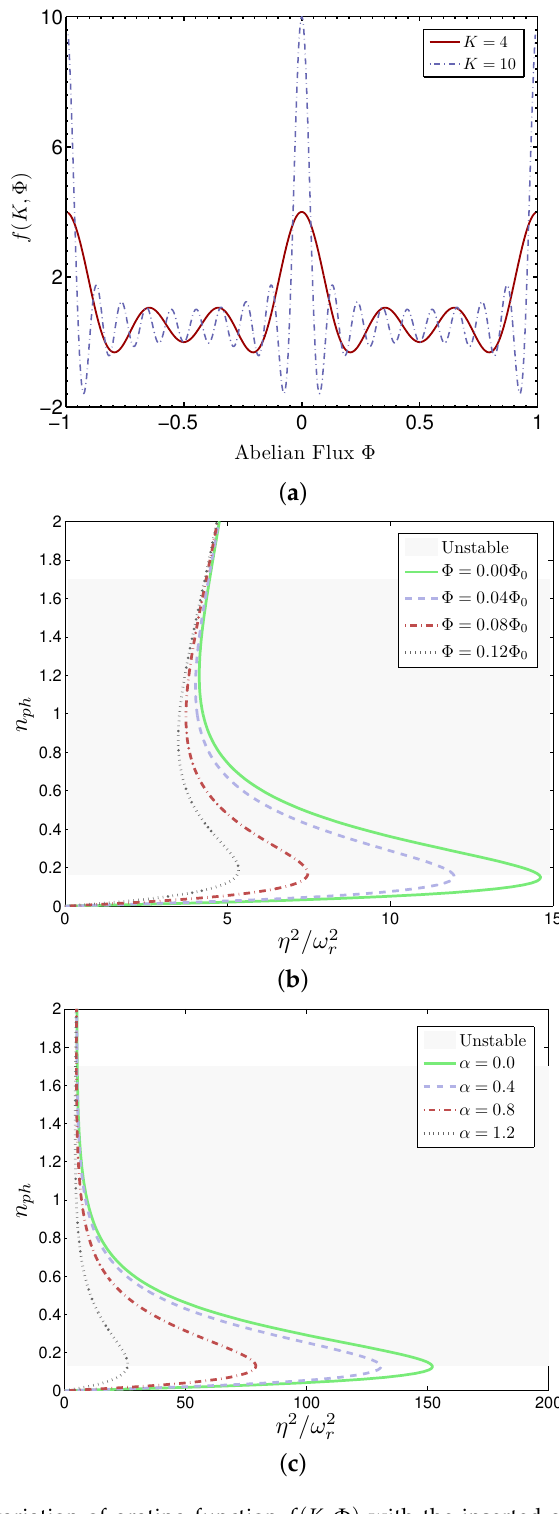
Figure 11. ( a ) The variation of grating function f ( K , Φ ) with the inserted abelian flux. The graph legends indicate the size of the lattice. In a large lattice limit the grating function does not sense the variation of Φ ; The cavity spectrum for different fields: ( b ) abelian fields (with fixed non-abelian field, α = − β = π /2 − 0.15); ( c ) non-abelian fields (with fixed abelian field, Φ = 0.08 Φ 0 ). The negative slope region is the unstable (gray) part of the spectrum. From [34]. (Reprinted figures with permission from Padhi, B.; Ghosh, S. Phys. Rev. A 2014, 90, 023627. Copyright (2014) by the American Physical Society. Source: